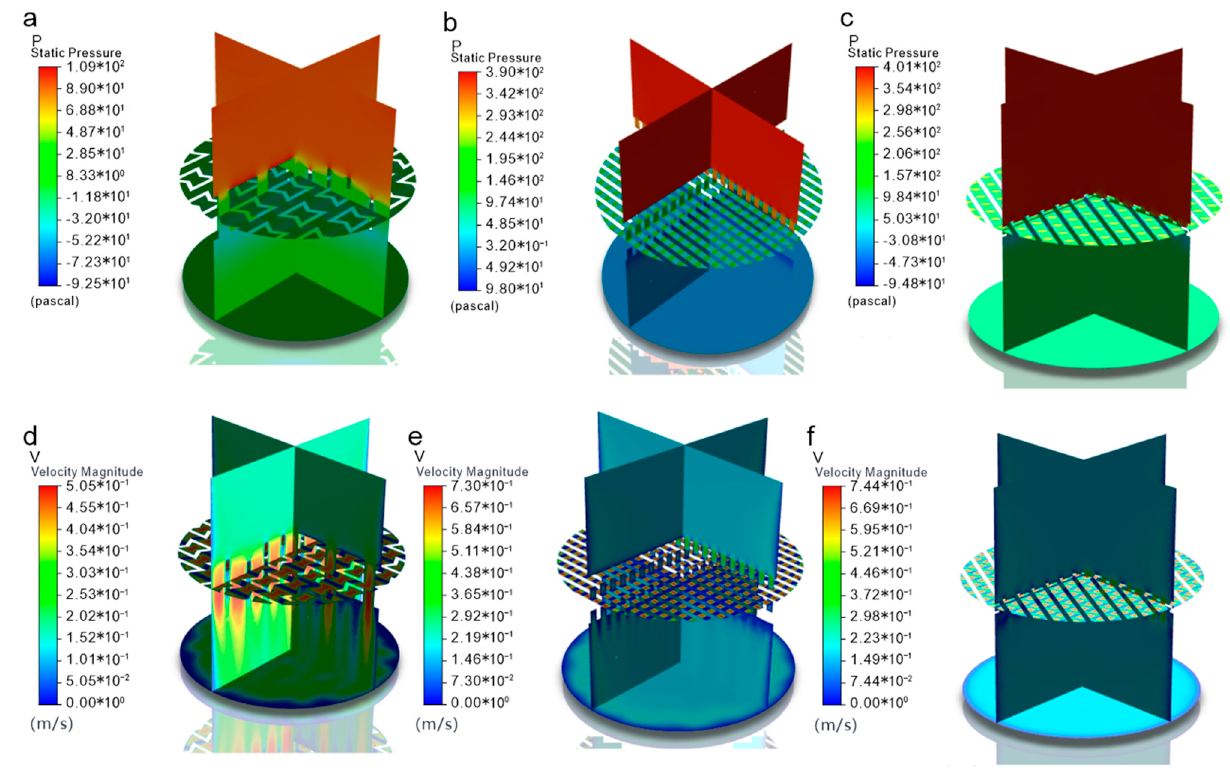
Figure 9. Velocity distribution of different filled structures at the same porosity ( a – c ) Pressure distribution ( d – f